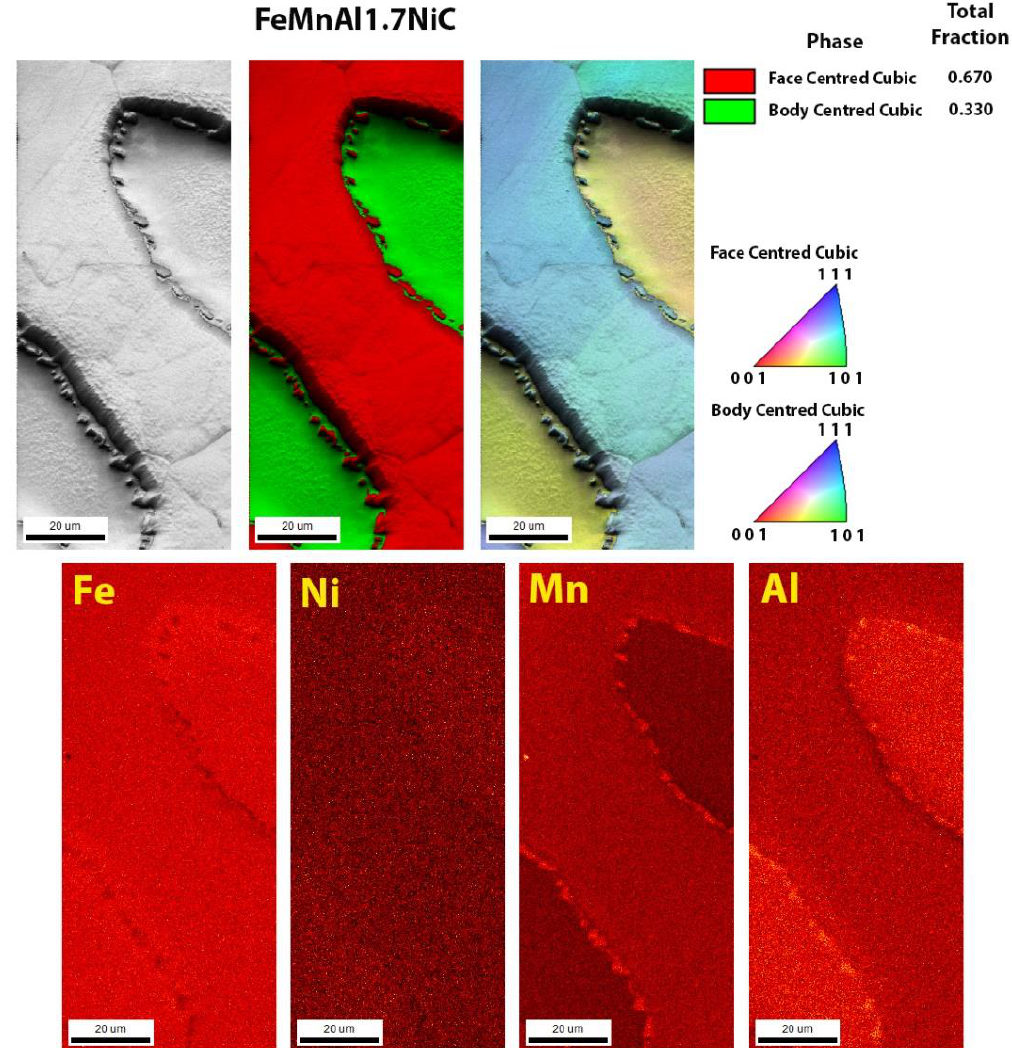
Figure 7. Electron backscattered diffraction analysis of a sample as-cast FeMnAl1.7NiC sample and SEM EDS (Energy- dispersive X-ray spectroscopy) elemental mapping of Fe, Ni, Mn, and Al.